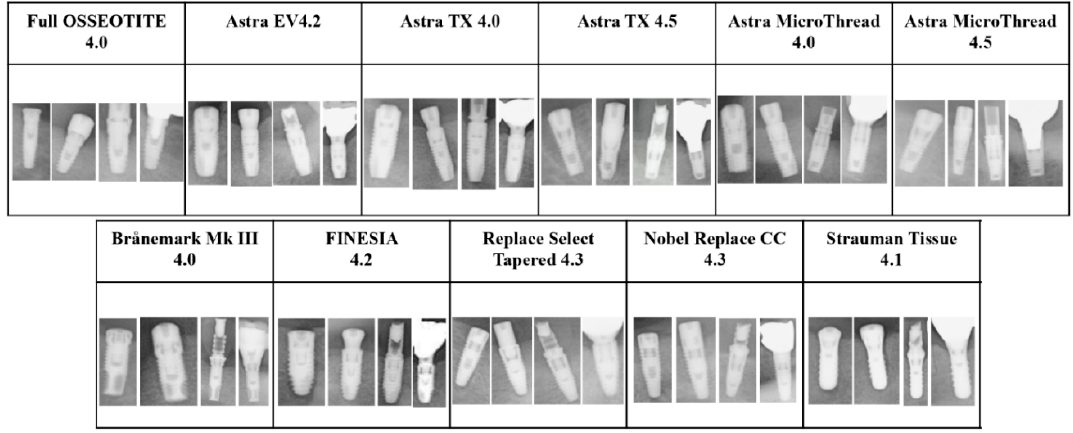
Figure 2. Eleven types of dental implant systems cropped from panoramic radiographs. The images of each system include implant fixtures, dental implants with healing abutments, dental implants with provisional settings, and implants with final prostheses.